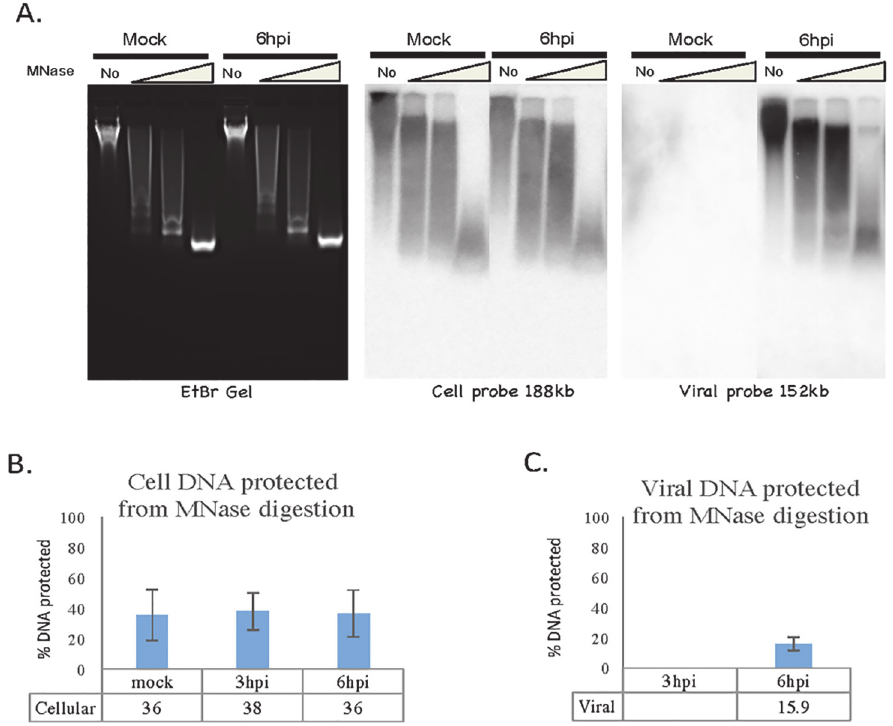
Fig 3. Fraction of DNA MNase Resistant. Similar to our previous nucleosome studies, MNase digestion coupled with gel electrophoresis was used to determine the % DNA protected by nucleosomes [25]. Cells were digested with various concentration of MNase and DNA extracted following which they were separated by 1.5% agarose gel electrophoresis ( A .), transferred to Hybond — N+ membrane by Southern blot and hybridized to Cell or HSV-1 32 P labeled probes ( B. and C ). Total DNA and 150bp protected band DNA were measured by a Typhoon phosphorimager. % DNA protected was calculated as 150bp DNA band divided by total DNA. All data are the averages of three independent experiments, and error bars represent the standard